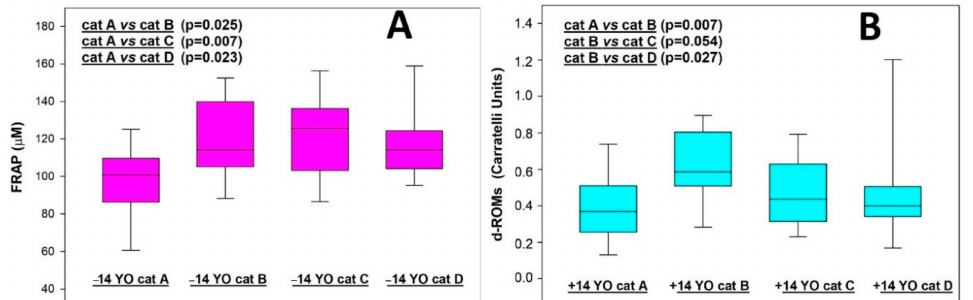
Figure 4. ( A ): Box plots of the FRAP values of the < 14-years-old horses of the di ff erent housing categories. ( B ): Box plot of the WST values of the > 14 years old horses belonging to the di ff erent housing conditions. The comparisons were realized by Mann-Whitney